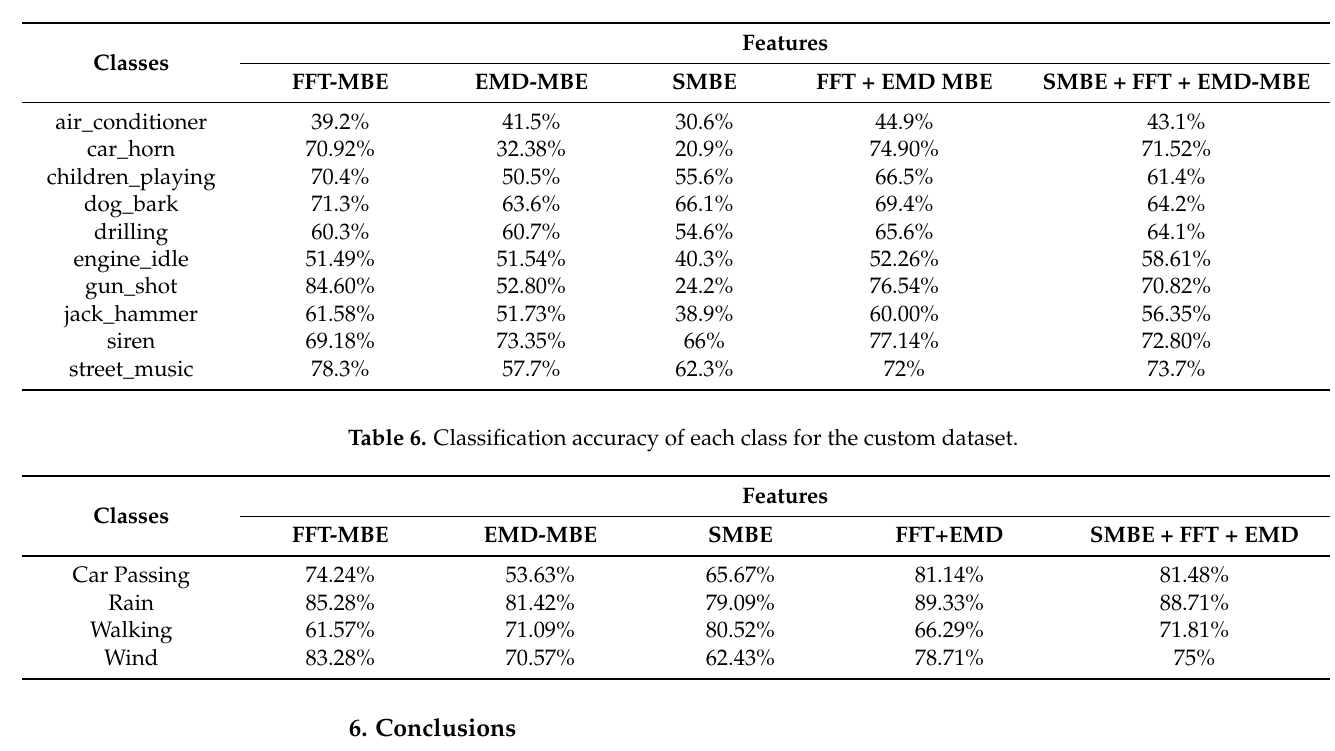
Table 5. Classification accuracy of each class for the Urbansound8k dataset.